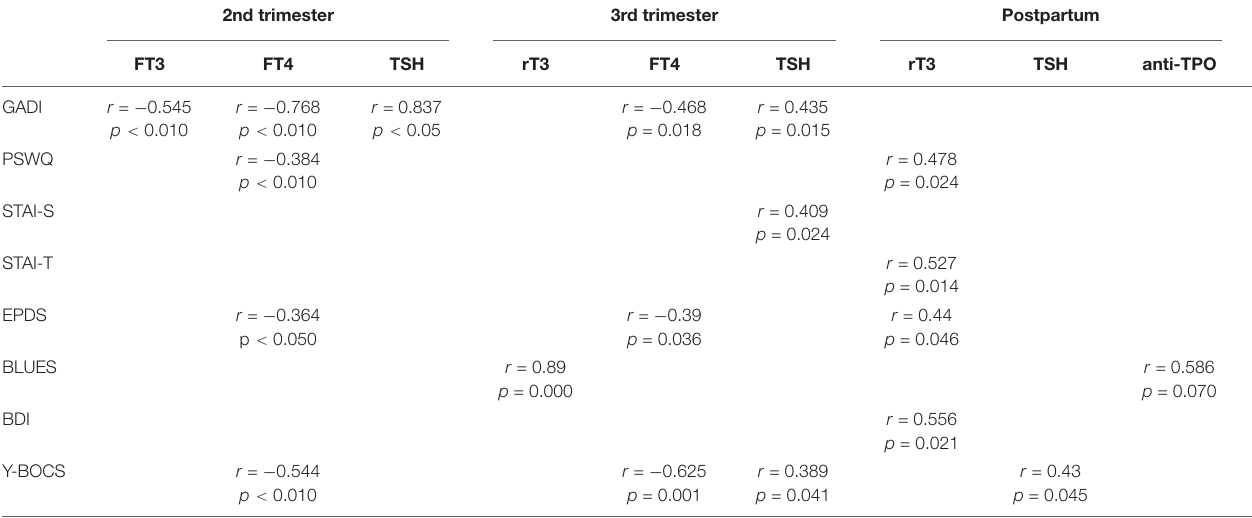
TABLE 2 | Significant correlations among hormonal and psychometric variables at the 2nd and 3rd trimesters and post-partum. 2nd trimester 3rd trimester